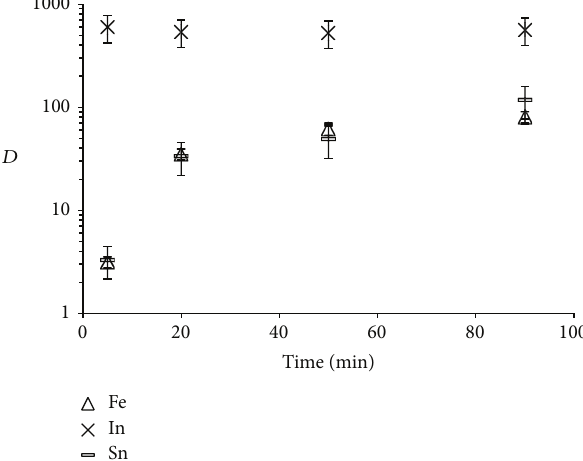
Figure 2: Kinetics of metal extraction using 0.1 M H 2 SO 4 and 0.1M D2EHPA in kerosene, 𝜃 = 1 . Mixing time of the mixtures was between 5 minutes and 2.5 hours under mechanical shaking at 1500 rpm and 293 ±